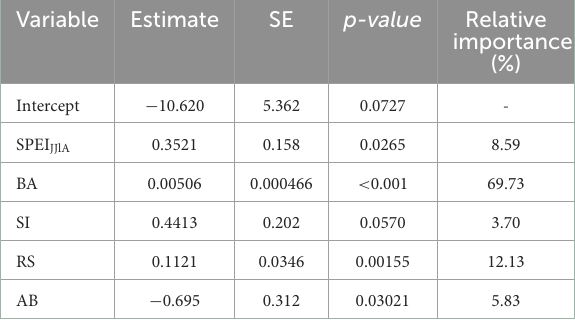
TABLE 3 Parameter estimates and the corresponding p -values of the linear mixed-effects models fitted to annual BAI.